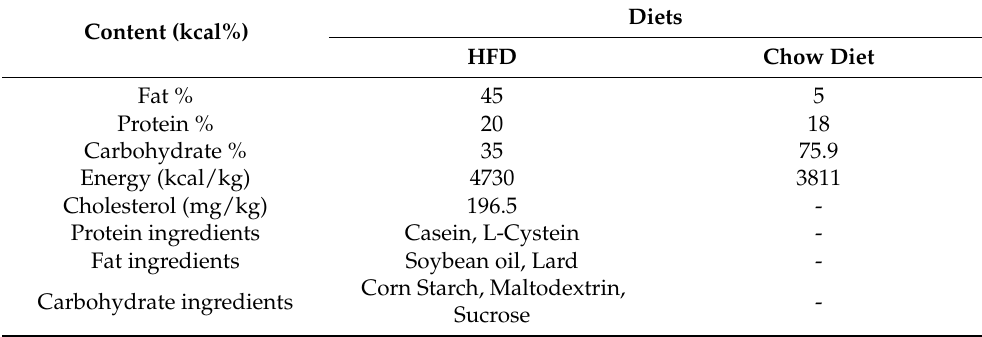
Table 1. The composition of HFD and chow diet.